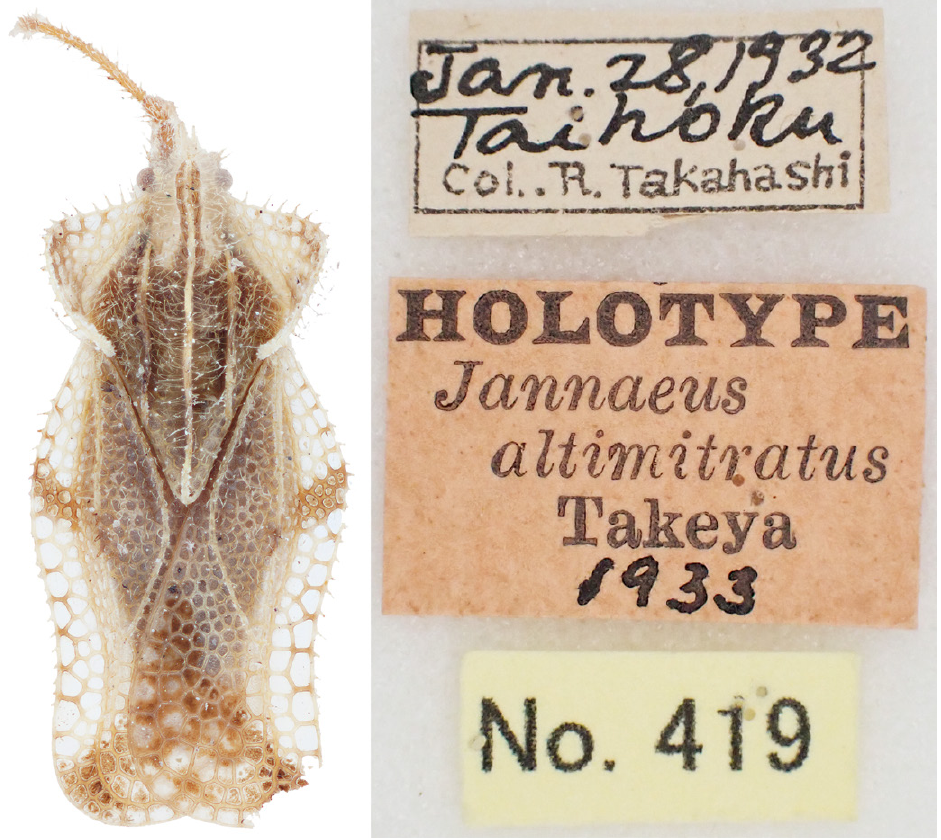
Figure 3. Male holotype of Lasiacantha altimitrata and its